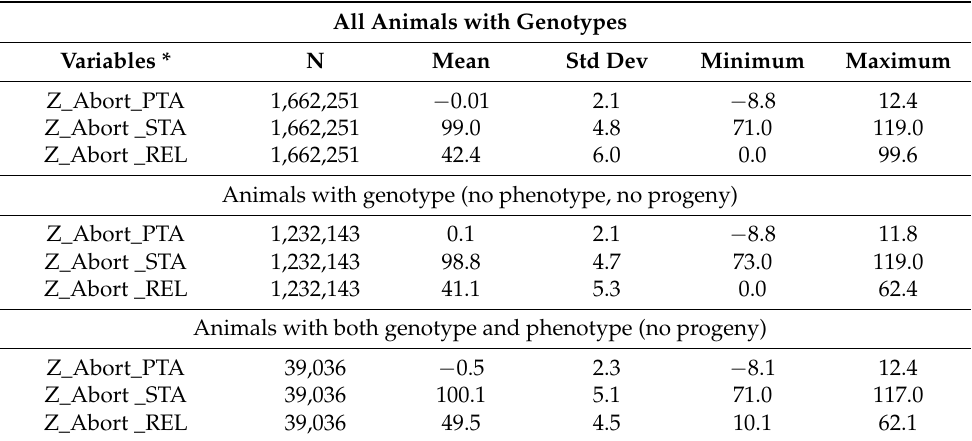
Table 3. Means, standard deviations, minimum and maximum of gPTAs, STAs, and reliabilities for different groups of animals for abortion in Holsteins.